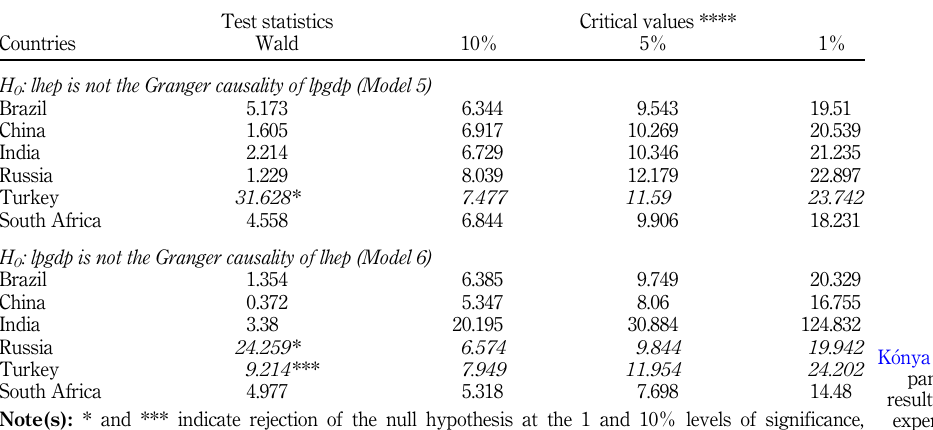
Table 4. K (cid:2) onya (2006)